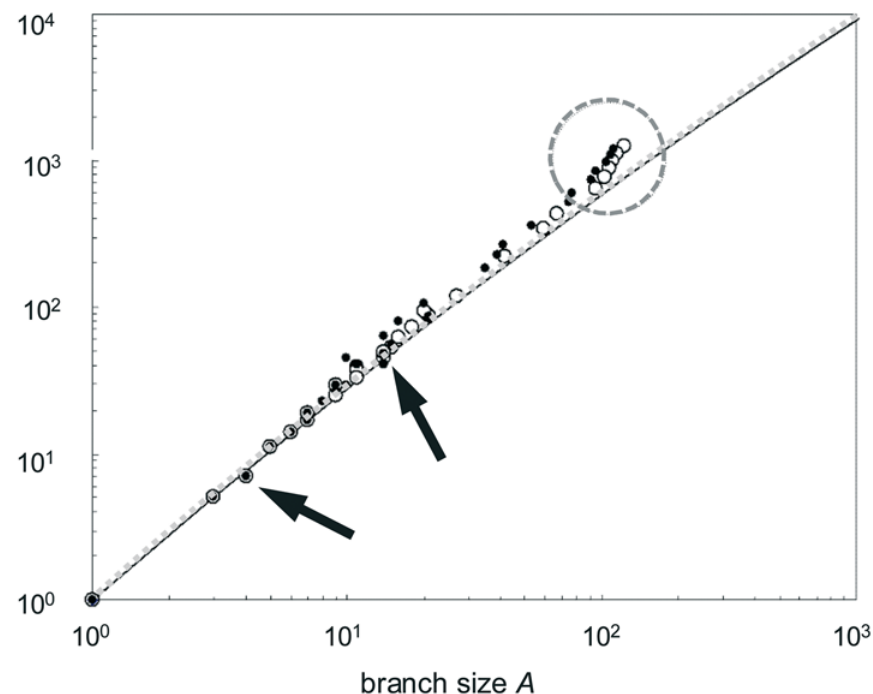
Figure 3. Relationship between branch size ( A ) and cumulative branch size ( C ) throughout two phylogenetic trees (shown in Fig. 2). Each data point represents a node. Notice the logarithmic scale on both axes. Open circles show data for tree A, solid dots stand for tree B. The diagonal line is the interpolated expectation from a random average, totally symmetrical tree. Arrows point at below-expectation values belonging to multifurcations. The dotted circle encloses rapidly diverging values belonging to outgroup and basal paraphyletic